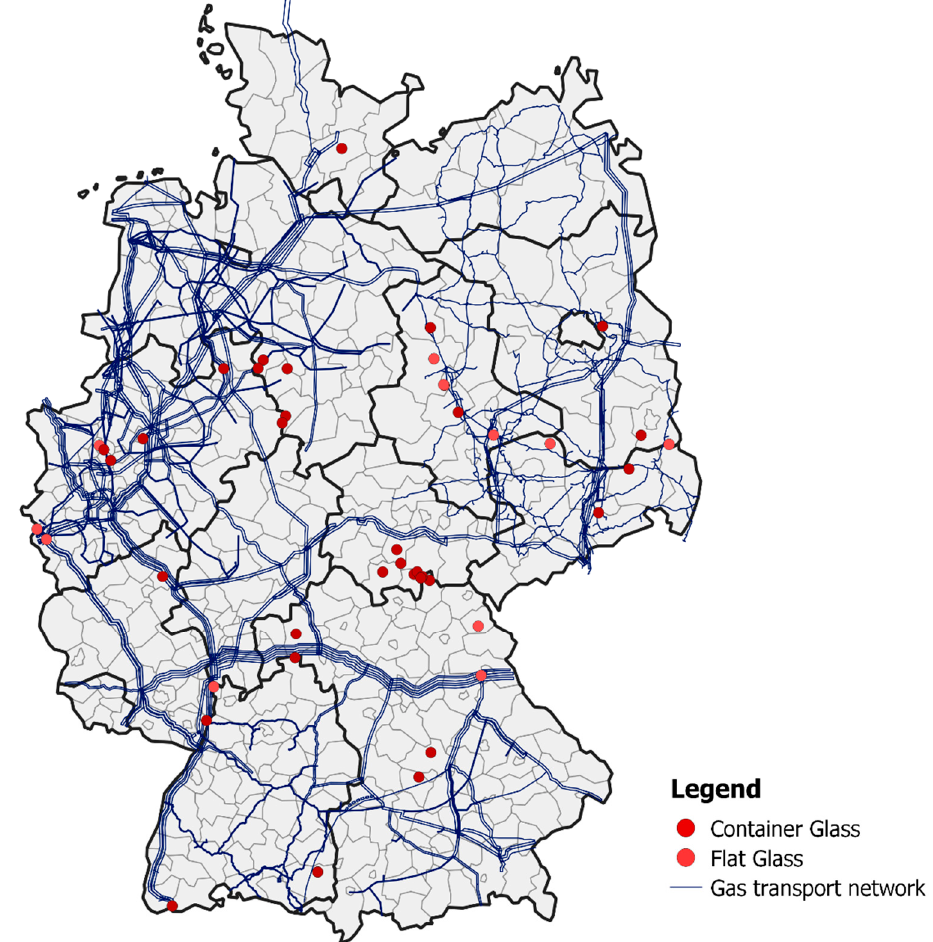
Figure 6. Glass production sites in combination with the current gas transportation network. Dark red circles are production sites for container glass and light red circles are production sites for flat glass. Based on [26,34] and updated from [27].